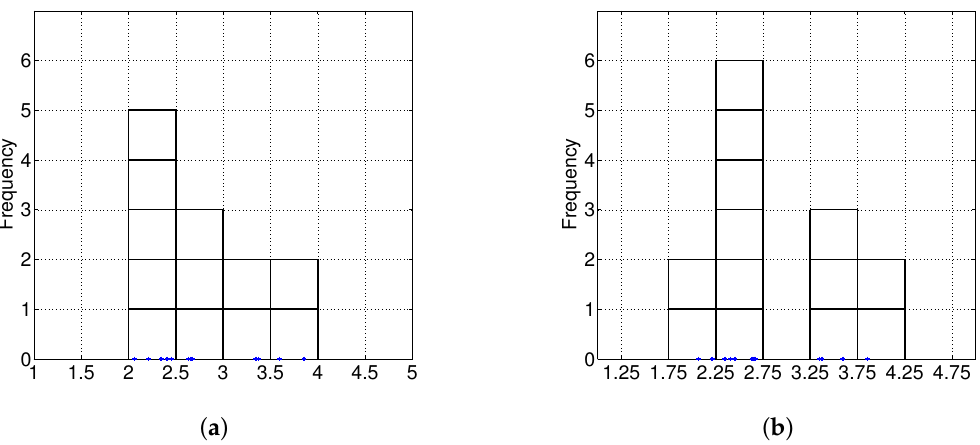
Figure 3. Effect of the start point in the histogram. ( a ) Start point = 0, bin width = 0.5; ( b ) Start point = 0.25, bin width =